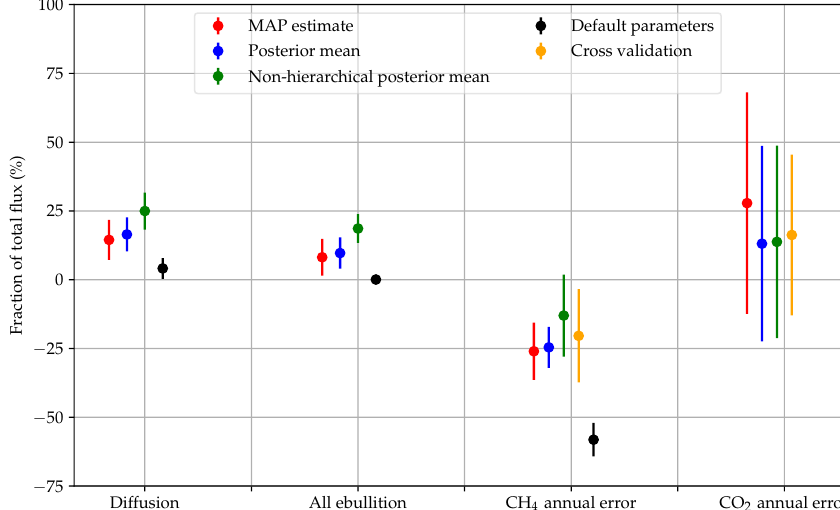
Figure 8. Fractions of the annual diffusive fluxes of the total fluxes. Means and 1 σ error bars are shown. Almost all ebullition takes place when the water table is below the peat surface, and hence it is emitted to the atmosphere as part of the diffusion flux. Plant transport is not shown, as it is very close to the complement of the diffusive flux: together, these two streams add up to more than 98% of the total flux. Plant transport variation is very close to that of diffusion. On the right side of the figure, the average annual errors are shown for the interannual variation of the fluxes. The results of the cross validation of the regression modeling of the hierarchically varying parameters, discussed in Sect. 5.6, are drawn in orange. The “default” parameters produce carbon dioxide fluxes that are above the upper limit of the chart.